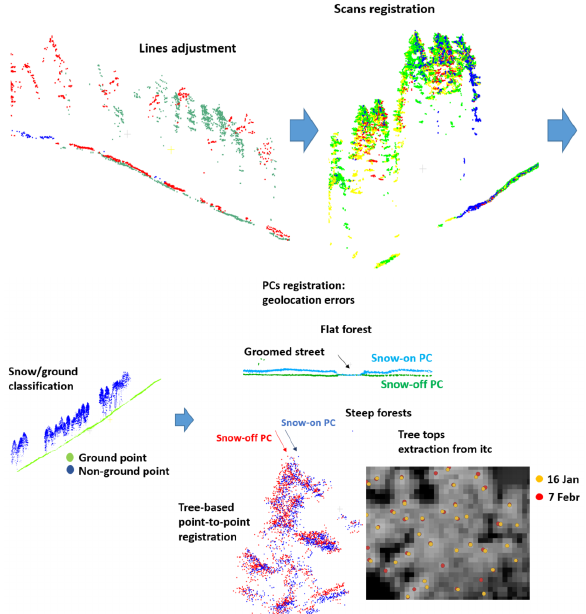
Figure 2 . Point Cloud-level processing workflow.